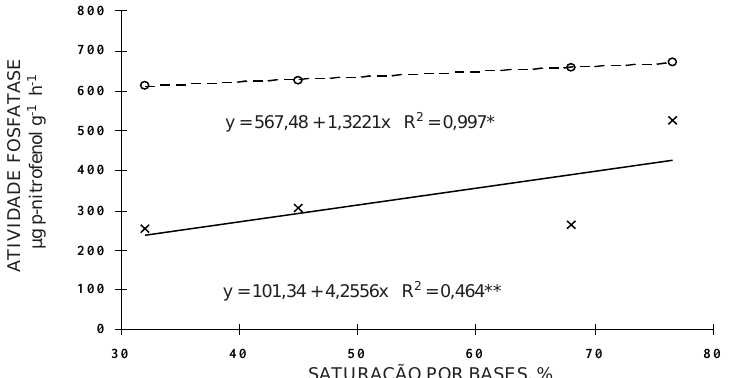
Figura 2. Atividade das fosfatases ácidas (--- o ---) e alcalinas ( (cid:190)(cid:190)(cid:190)(cid:190)(cid:190) x (cid:190)(cid:190)(cid:190)(cid:190)(cid:190) ) em função da saturação por bases em um solo do tabuleiro costeiro de Umbaúba